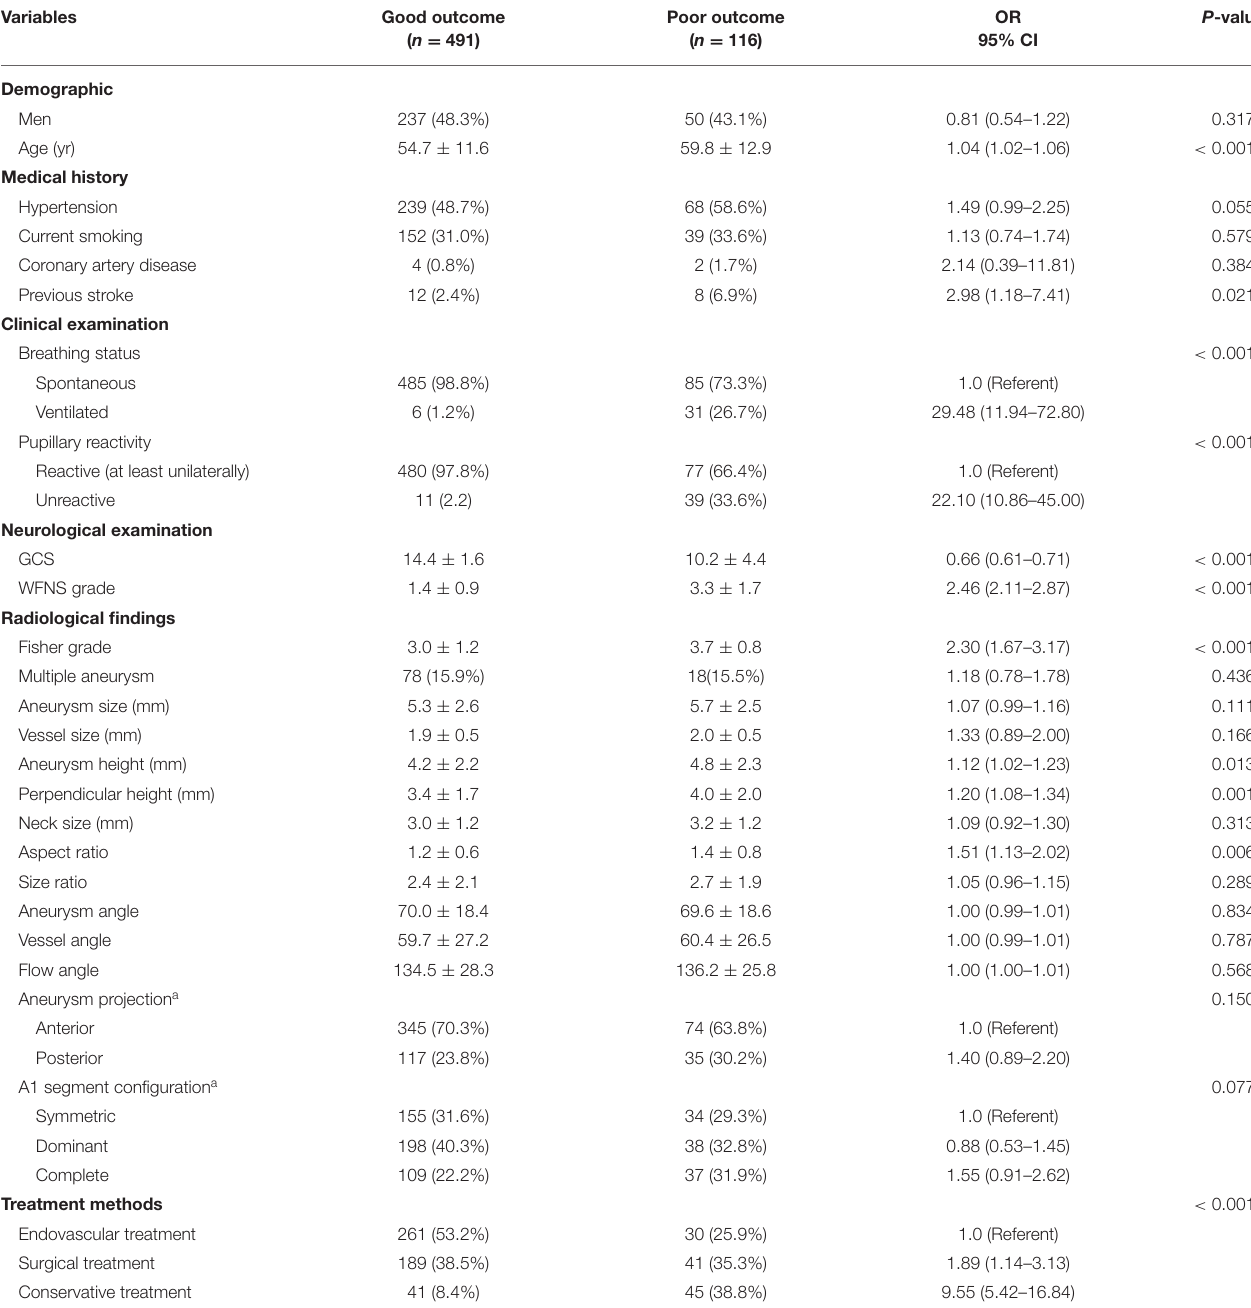
TABLE 1 | Baseline